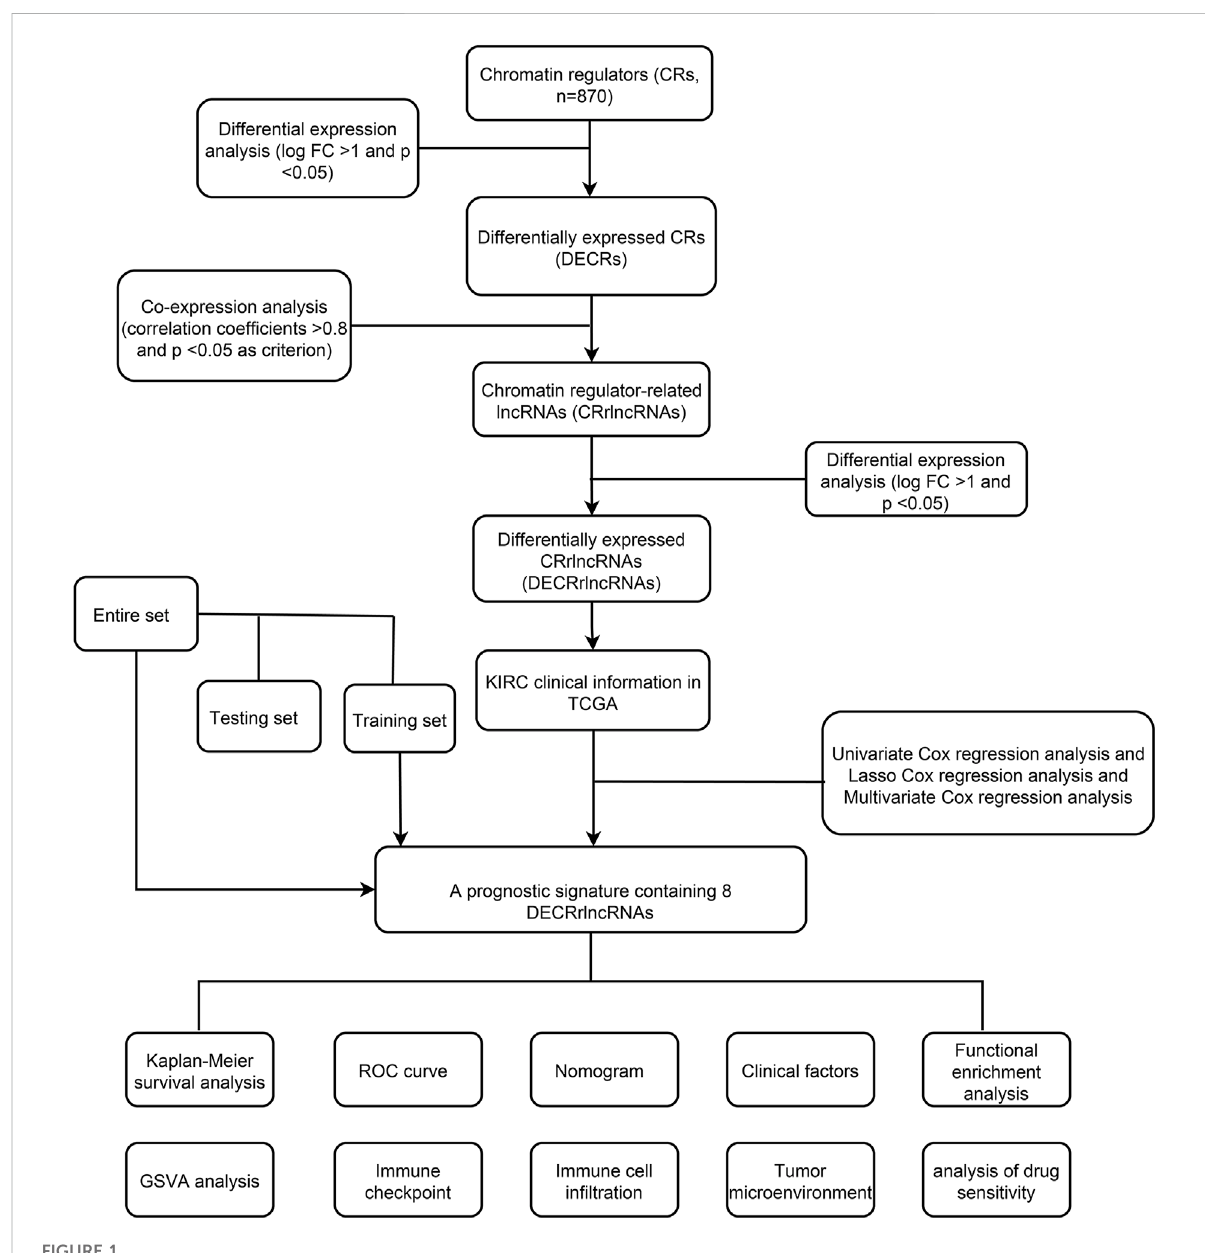
FIGURE 1 Work fl ow of this